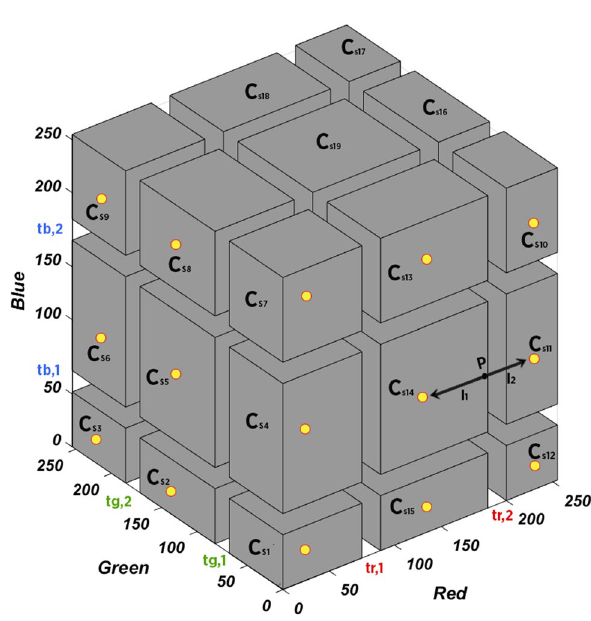
Fig. 3 Clustered RGB color space and cluster center of